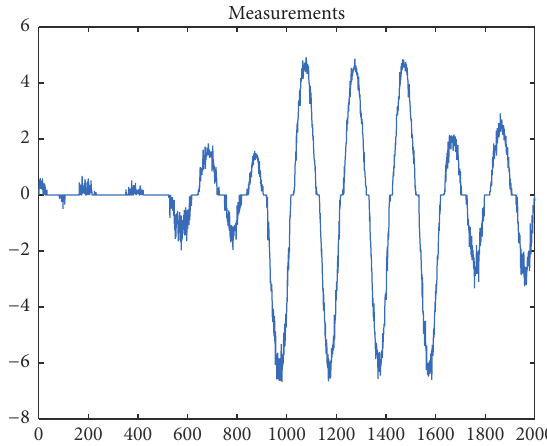
Figure 1: Observed measurements of